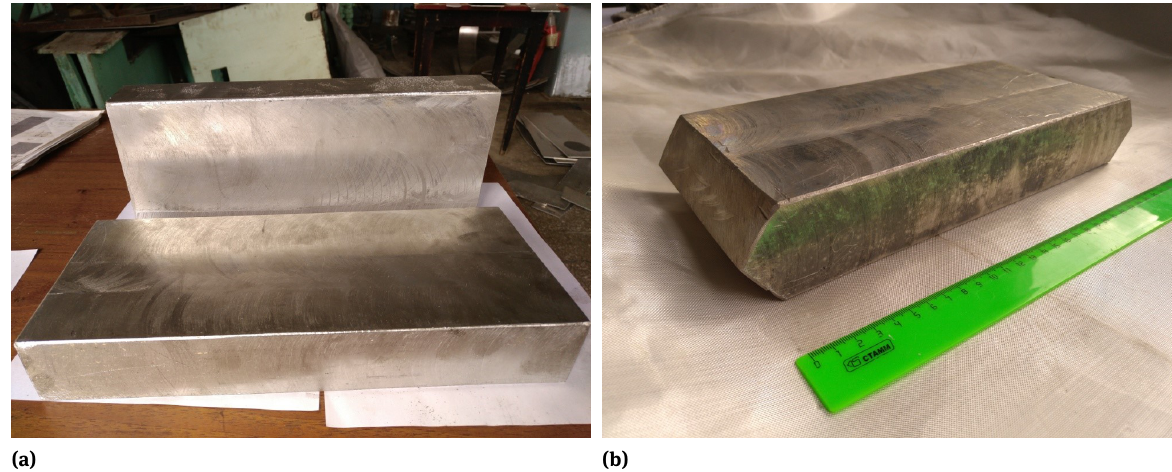
Figure 3: View of cast billets from the investigated alloys after milling